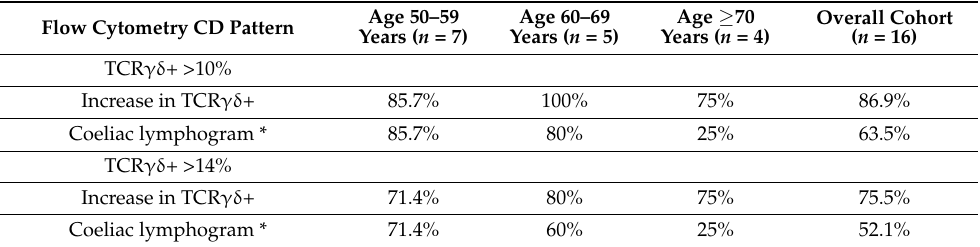
Figure 2. Box-plot chart of CD3 − cells in CD patients with villous atrophy ( n = 71), depending on the different age groups ( p = 0.25; Kruskal–Wallis test). Figure 1 . Box-plot chart of TCR γδ + cells in CD patients with villous atrophy ( n = 71), depending on the different age groups ( p = 0.009; Kruskal–Wallis test). Table 3. CD diagnosis sensitivity of the two coeliac cytometric patterns in patients with Marsh 1 in function of the age